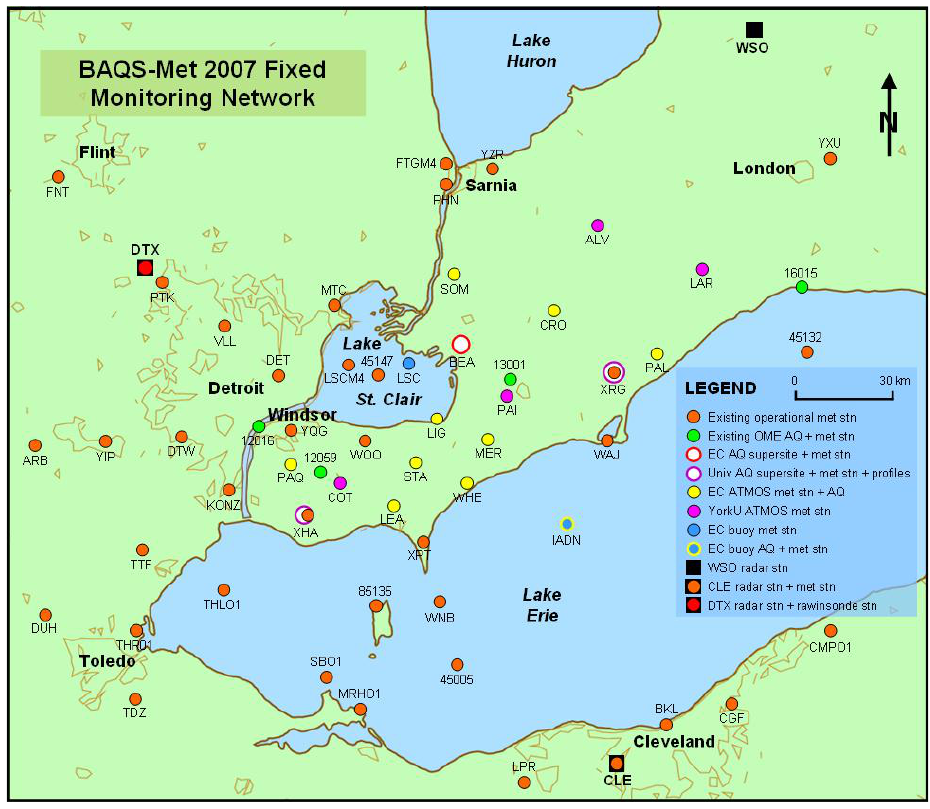
Fig. 1. Map showing the BAQS-Met study domain and fixed monitoring network. Light brown lines indicate urban boundaries. The terrain is generally flat to gently rolling and land use is predominantly agricultural with the exception of large urban/industrial areas (e.g. Detroit and